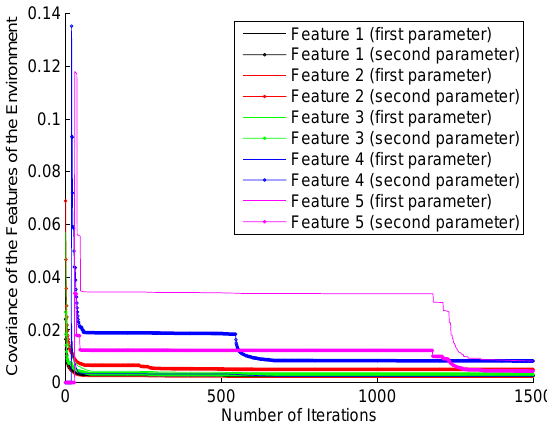
Covariance evolution of a same set of features of Figure 12 estimated by EKF-SLAM with the covariance ratio feature selection approach.